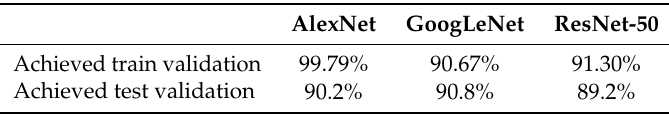
Table 2. Outputs from CNNs for image classification.